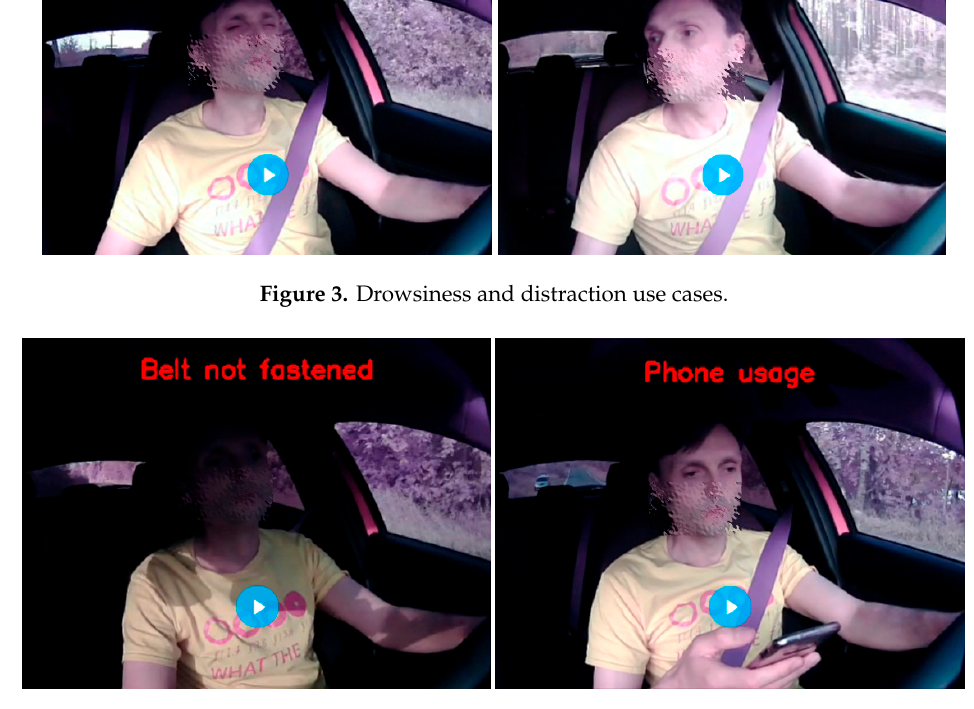
Figure 4. Unfastened belt and smartphone usage use-cases.